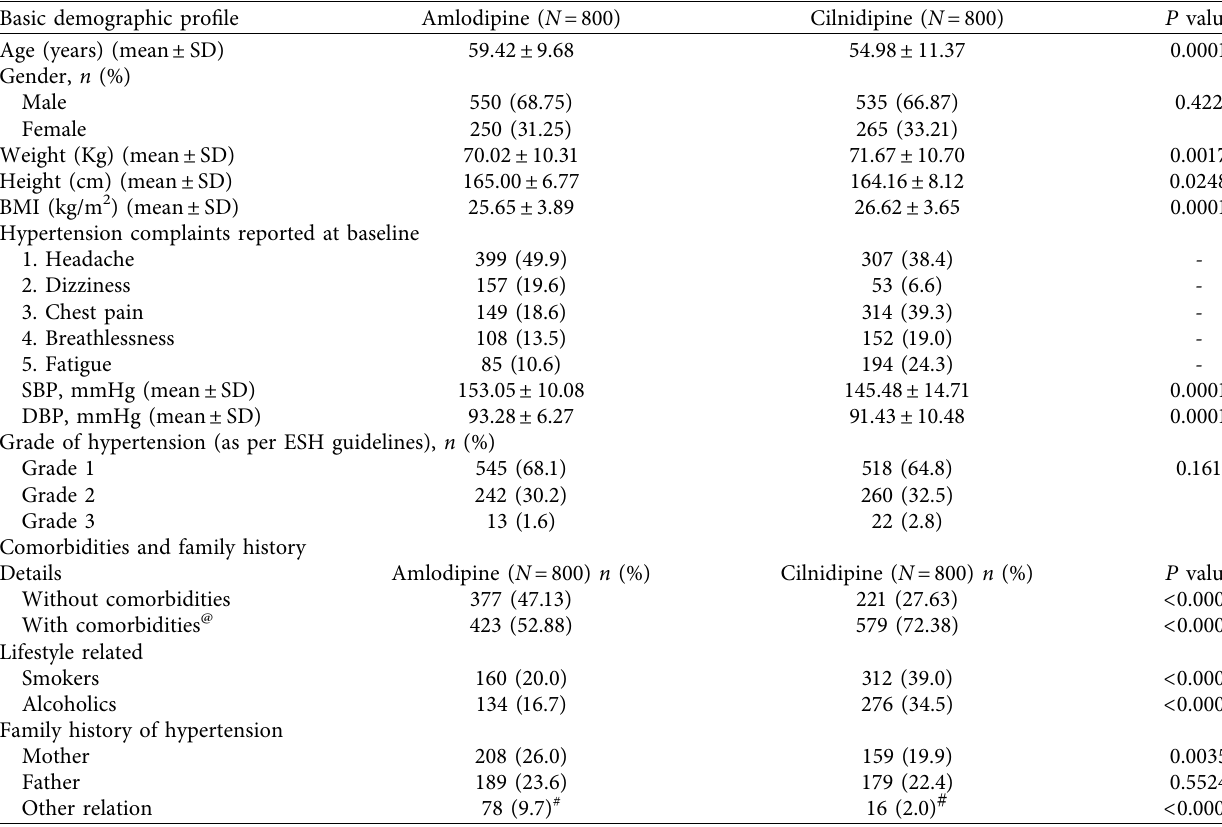
Table 1: Baseline characteristics, comorbidities, and family